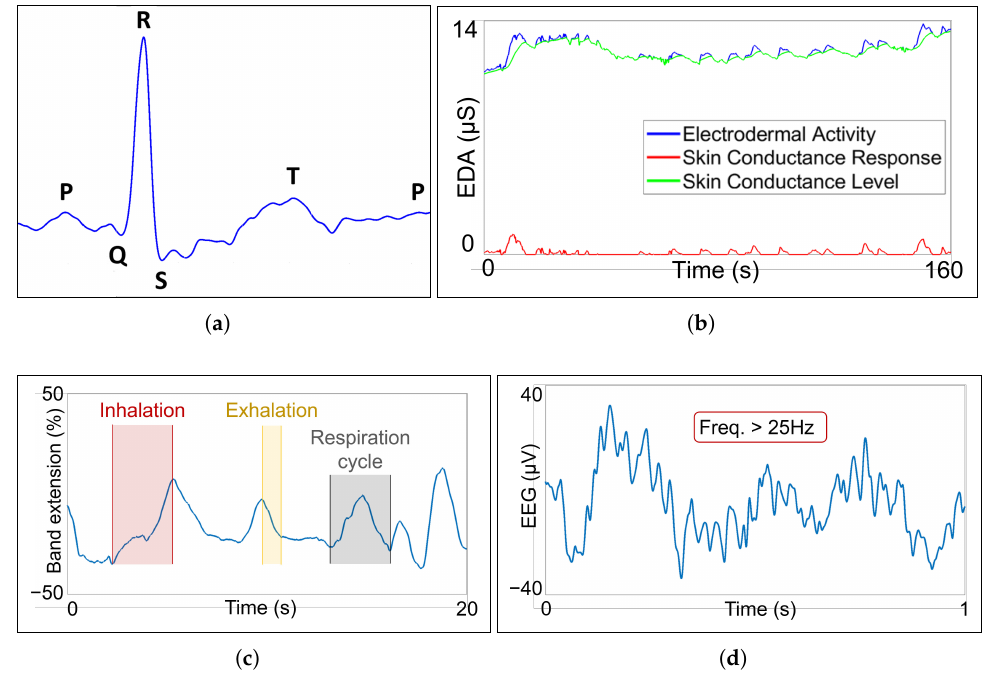
Figure 1. Relation between measured bio-signals and psychophysical aspects.